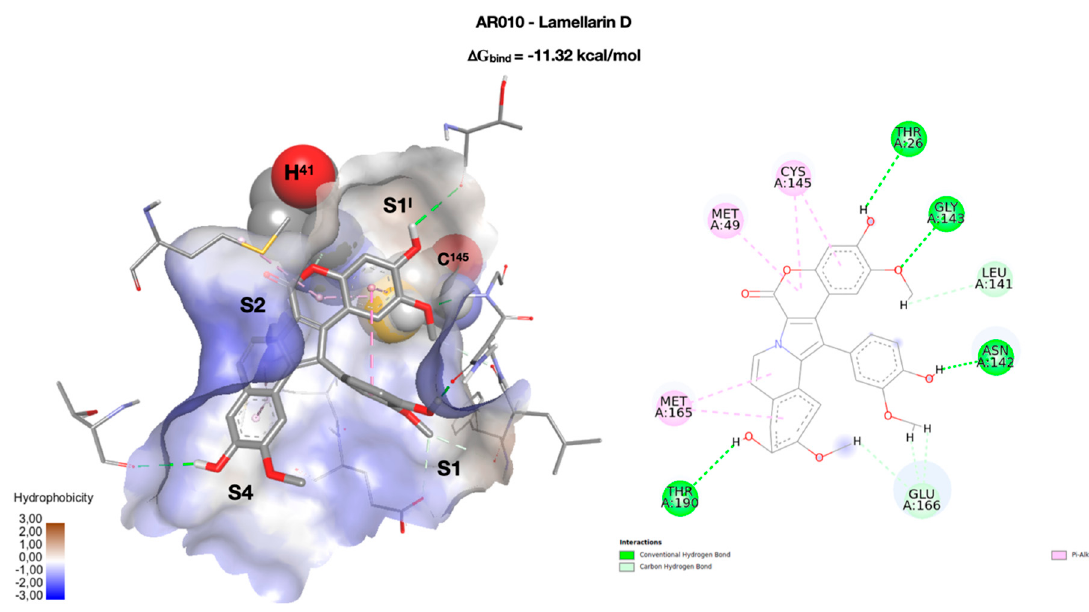
Figure 3. On the left, the best docking conformation of lamellarin D (AR010 in stick) inside the enzymatic binding site. The binding site is represented as a solvent accessible surface (SAS) colored according to the hydrophobicity of the residues (wireframe). The two key residues of the catalytic dyad (H 41 and C 145 ) are rendered in CPK, and the four binding pockets (S1 I , S1, S2, and S4) occupied by the molecule are highlighted. On the right, a two-dimensional representation of the molecular interactions between the ligand and the enzyme. The colors used refer to the different interactions, as indicated in the legend.